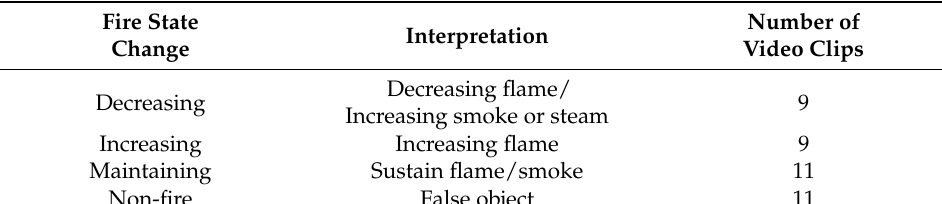
Table 11. Collected video clips from YouTube [26].